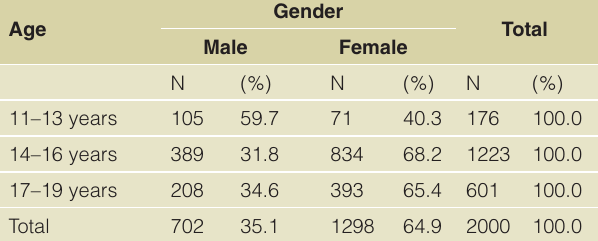
Table 5. Descriptive analysis of age and gender